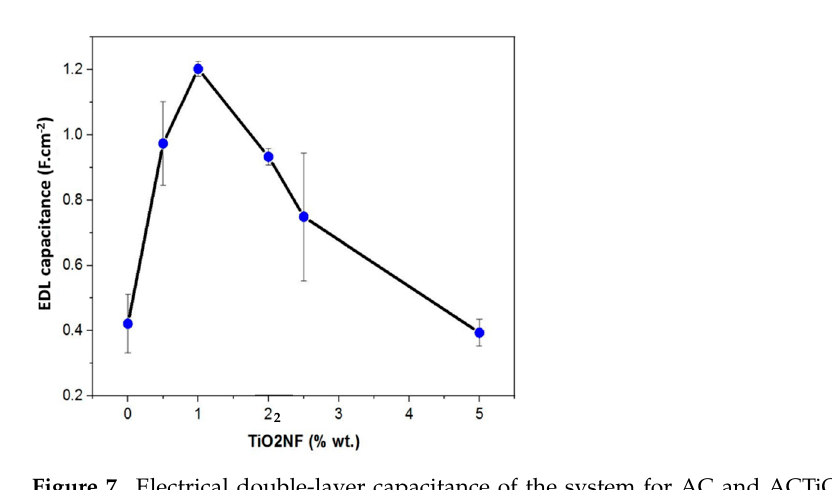
Figure 7. Electrical double-layer capacitance of the system for AC and ACTiO 2 NF-x composite elec- trodes (ACTiO 2 NF–x where x = 0.5, 1.0, 2.0, 2.5, and 5.0 wt.% TiO 2 NF).